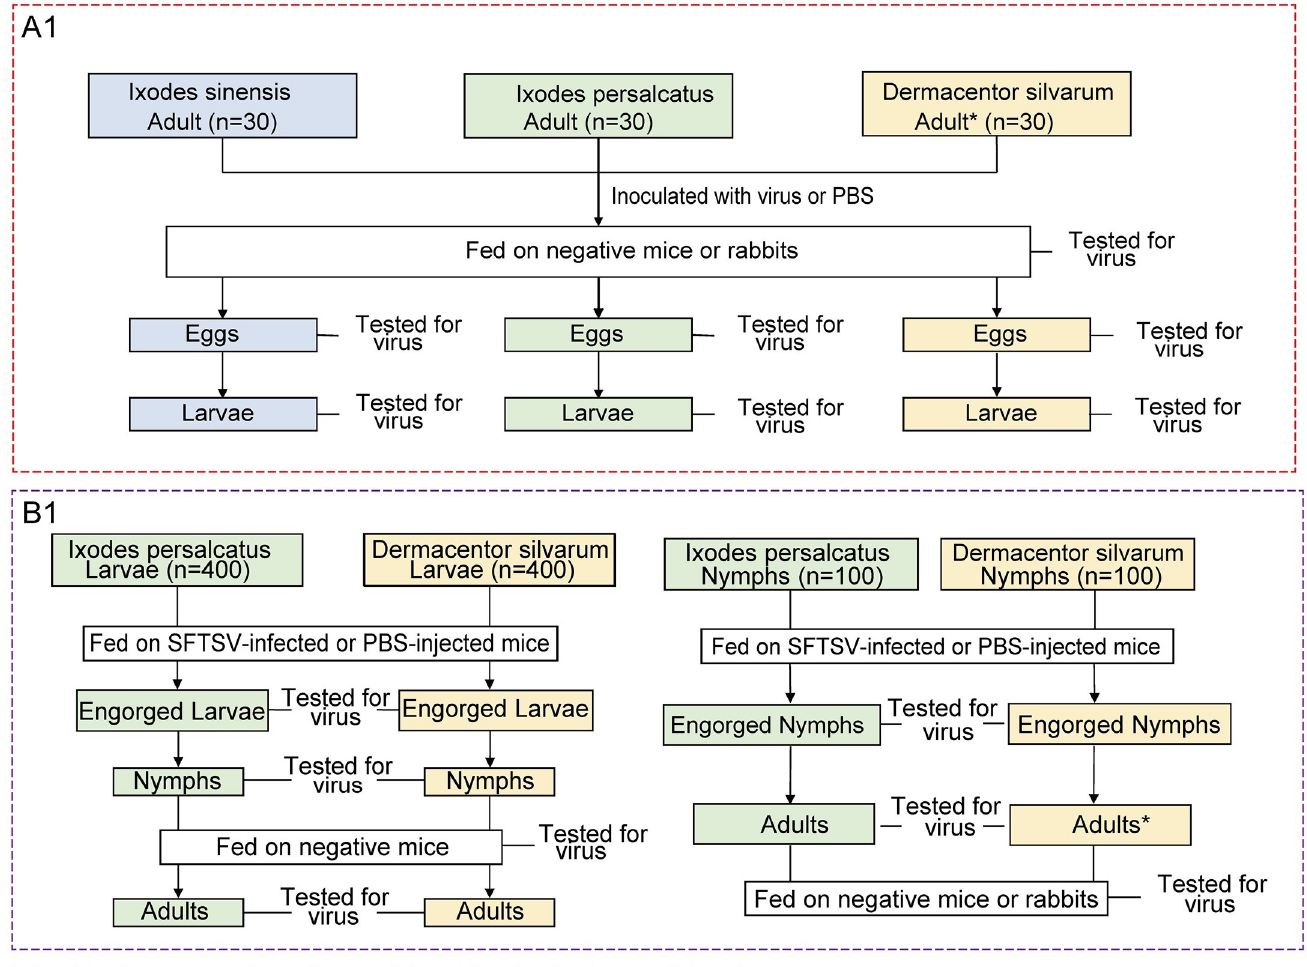
Fig 1. Framework of experimental transmission study of SFTSV. (A) Transovarial Transmission. Thirty adults for each three tick species that were microinjected with SFTSV cell culture dilution (3.65 × 10 6 PFU/ml) were used as SFTSV group. Thirty adults for each three tick species microinjected with PBS were used as control group. (B) Transstadial Transmission. To determine transstadial transmission of SFTSV by two tick species, we fed larvae and nymphs on SFTSV-infected mice in the SFTSV group and fed larvae and nymphs on PBS-injected mice in the control group. In larval or nymph acquisition feeding, the engorged larvae or engorged nymphs were tested for SFTSV by RT-PCR before or after molting.